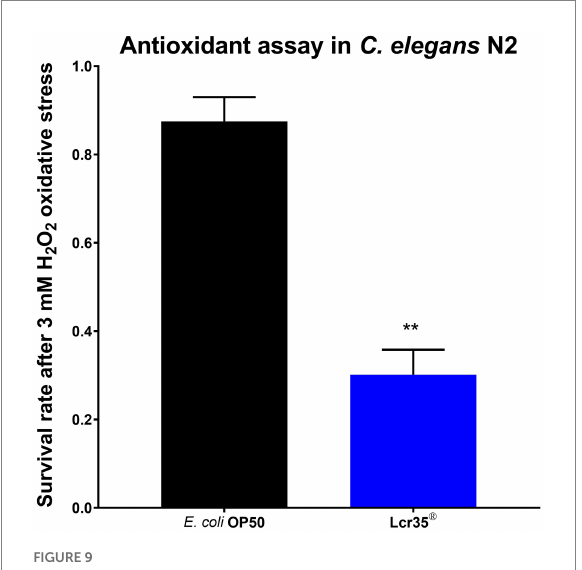
FIGURE 9 Antioxidant assay in C. elegans . Survival upon a 3 mM H 2 O 2 treatment for 3.5 h of C. elegans N2 strain fed for 5 days with E. coli OP50 or Lcr35 ® ( ** p <